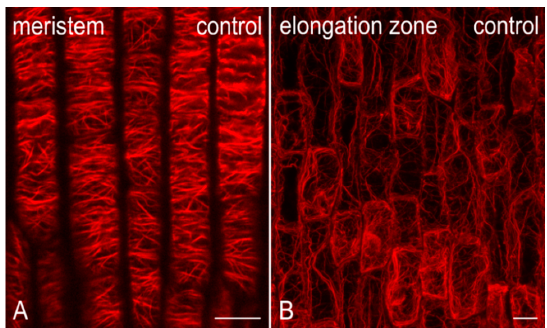
Figure 1. Single cortical confocal laser scanning microscope (CLSM) section ( A ) and maximum intensity projection of serial CLSM sections ( B ) of control Oryza sativa root, depicting protodermal cells in the apical meristem ( A ) and epidermal cells in the elongation zone ( B ), after F-actin staining. Root tips in both images point towards the bottom of the page. Control meristematic cells exhibit abundant fine cortical actin filaments, with a dominant transverse orientation ( A ), while elongating cells typically exhibit large, longitudinal subcortical F-actin cables ( B ). Scale bars: 10 µ